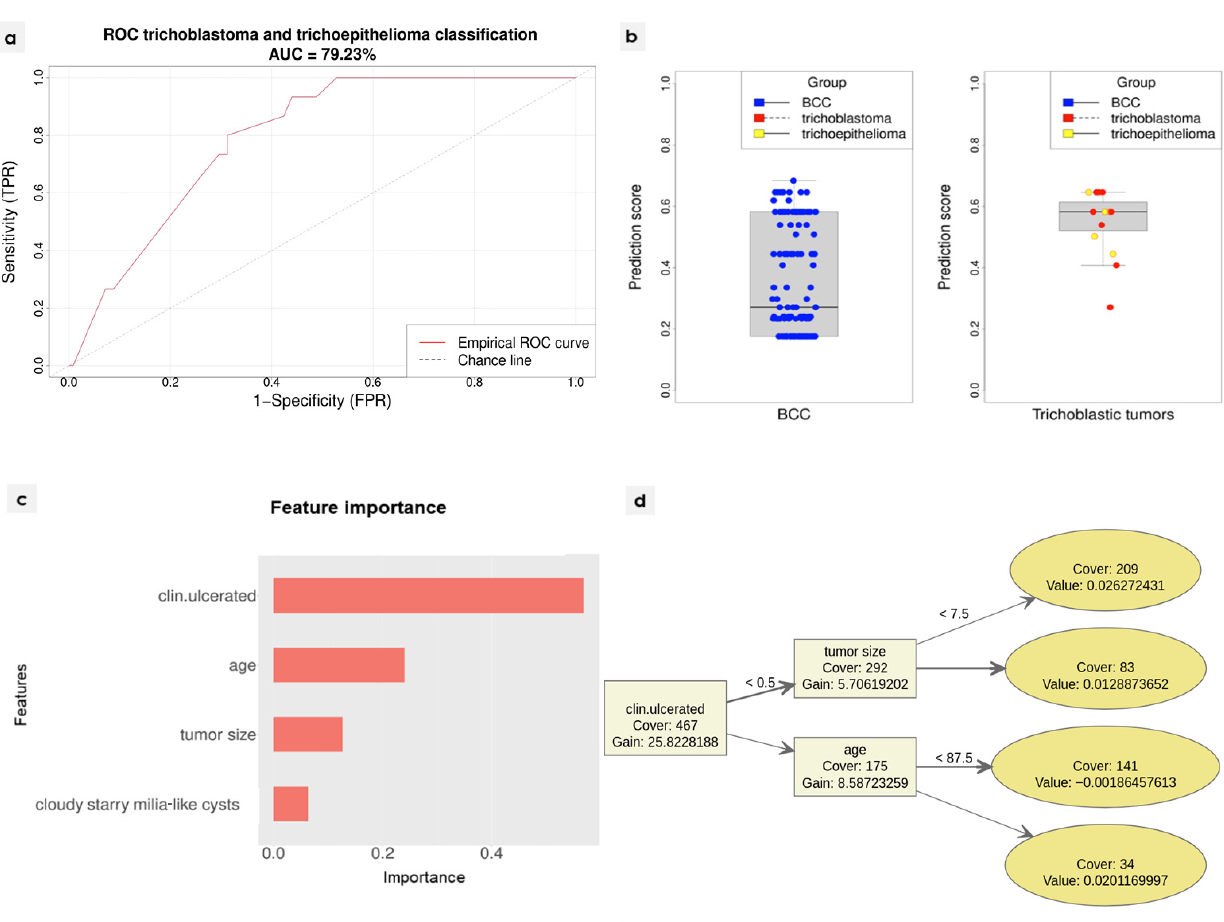
dermoscopy shows branched (arborizing) vessels (red arrow), superficial fine telangiectasia (violet arrow), central ulceration (black arrow), brown dots and globules (brown arrow), yellow globules (yellow arrow), and starry milia-like cysts (white arrow) (Fotofinder Vexia; Camera Medicam 800 HD, × 20 magnification). ( c , d ) Nodular basal cell carcinoma; dermoscopy shows branched (arborizing) vessels (red arrow), brown dots (brown arrow), starry milia-like cysts (white arrow), yellow globules (yellow arrow), and peripheral brown structureless areas (green arrow) (Fotofinder Vexia; Camera Medicam 800 HD, × 20 magnification).